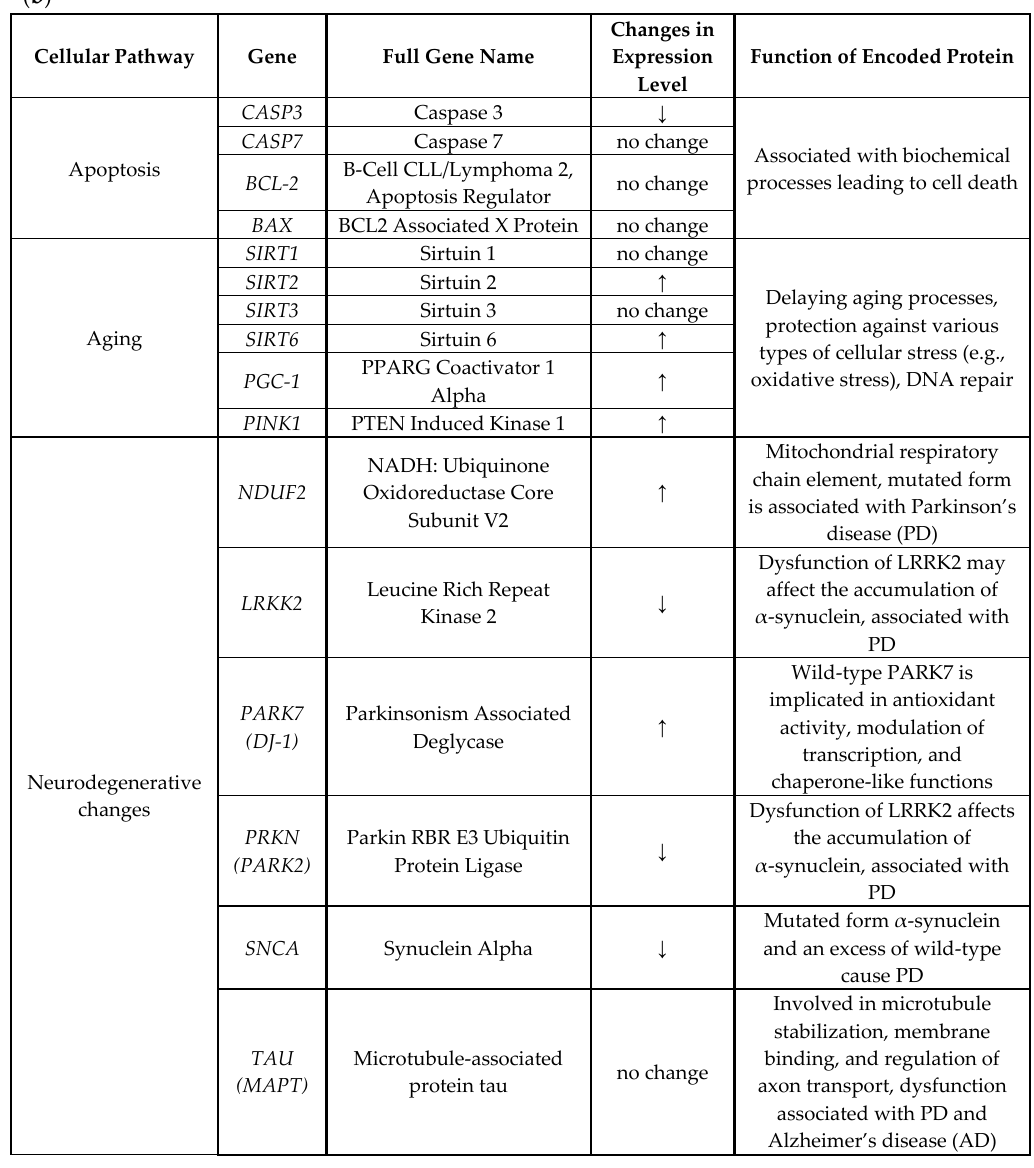
Figure 5. The expression level of selected genes in the brain tissue of aged rats fed with chicory extract-enriched feed. ( a ) Relative real-time PCR analysis of pro-apoptotic genes (CASP3, CASP7, BAX, BCL2), genes involved in delaying aging processes, different cellular type of stress, as well as DNA repair processes (SIRT1, SIRT2, SIRT3, SIRT6, PINK1, PGC1), and genes associated with neurodegenerative diseases (SYNC, LRKK2, PARK7, PRKN, TAU). The results are presented as the mean ± SD obtained from 6–8 individuals (treated vs. control) and three independent experimental repeats for each one. Statistical significance (t-test). Two-tailed p -values below 0.05 were considered statistically significant. (*) p < 0.05, (**) p < 0.01, (***) p < 0.001 ( b ) Table summarizing the analyzed genes and the function of encoded proteins, as well as their involvement in main cellular processes. Up arrow (up-expression); Down arrow (down-expression) We discovered that the diet rich in β -carbolines caused a significant decrease in caspase-3 (CASP3) expression level of about 20%, while the expression of the other analyzed genes involved in apoptosis remained on the level of the control animals. CASP3 is an effector factor responsible for